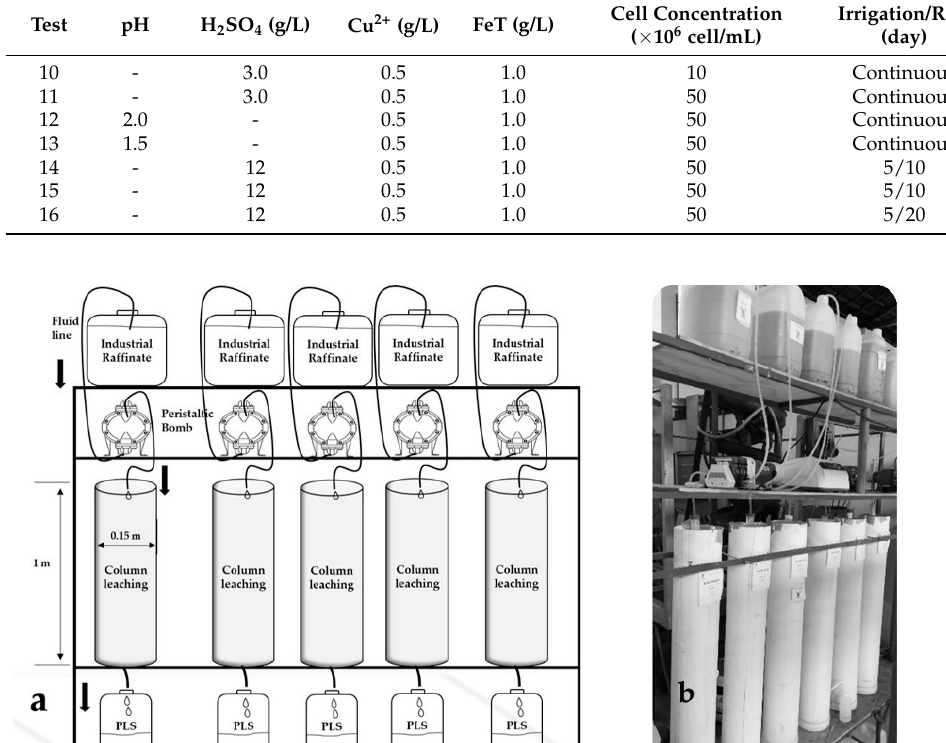
Figure 3. Schematic of the column leaching system ( a ) and real system ( b ). Table 3. List of tests performed on the chalcopyrite ore using columns 0.45 m in height.